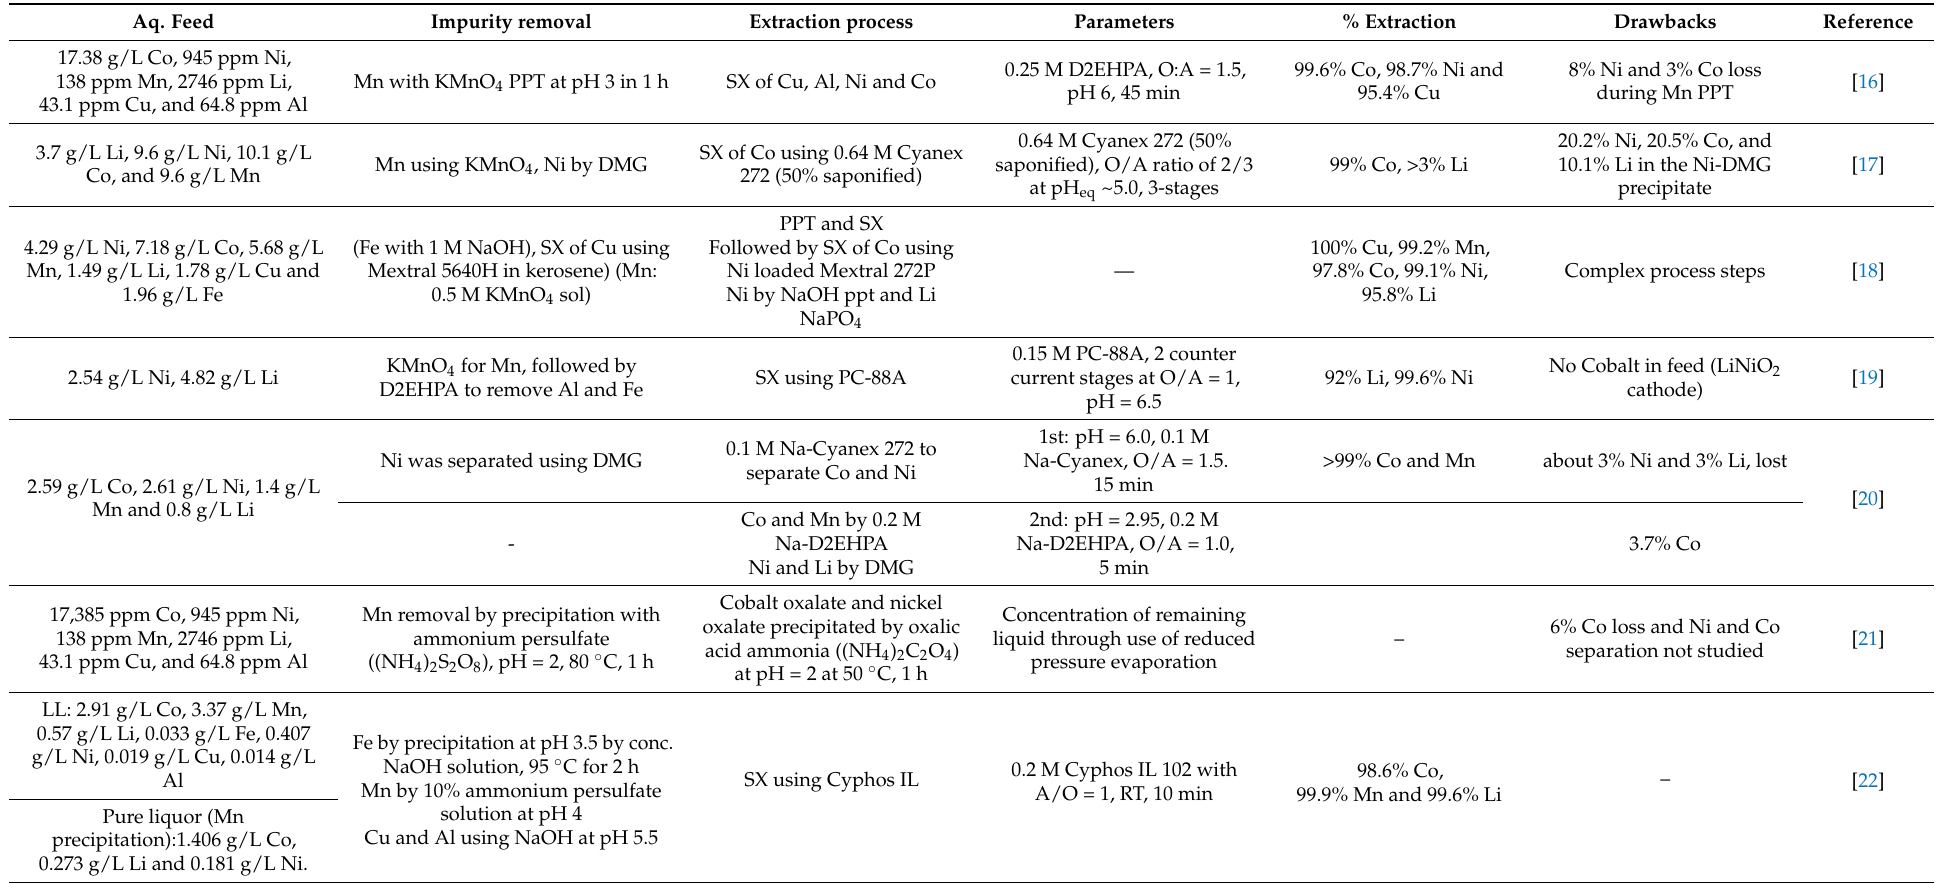
Table 1. Summary of available literature on the separation and purification of leach liquor obtained from spent